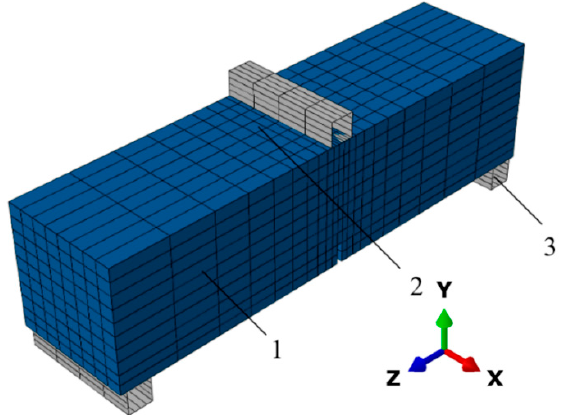
Figure 6. Finite element model for performing a virtual experiment to test a concrete beam using a three-point bend. 1—concrete beam; 2—loading bar; 3—supporting bar.